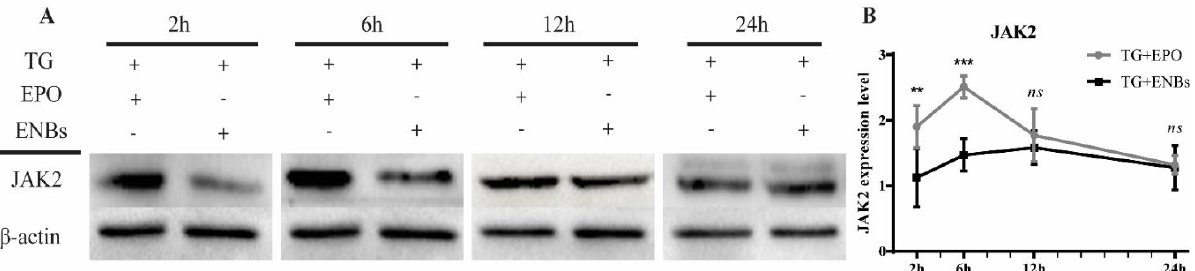
Figure 3. Viabilites of SH-SY5Y neuronal cells over 24 h. An MTS asssy was conducted. The control group was the cell-only group. The data are shown as the mean ± SD (error bars).